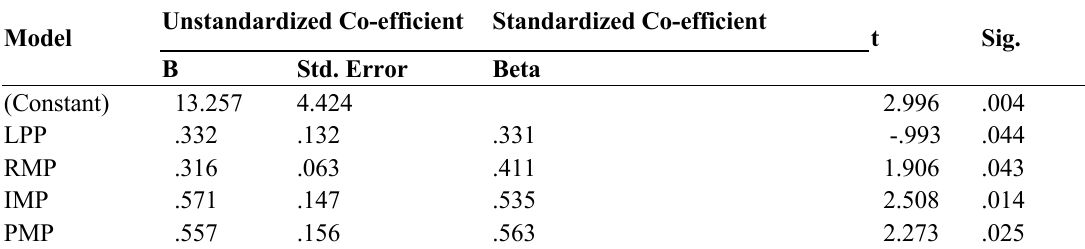
Table 4: Co-efficient